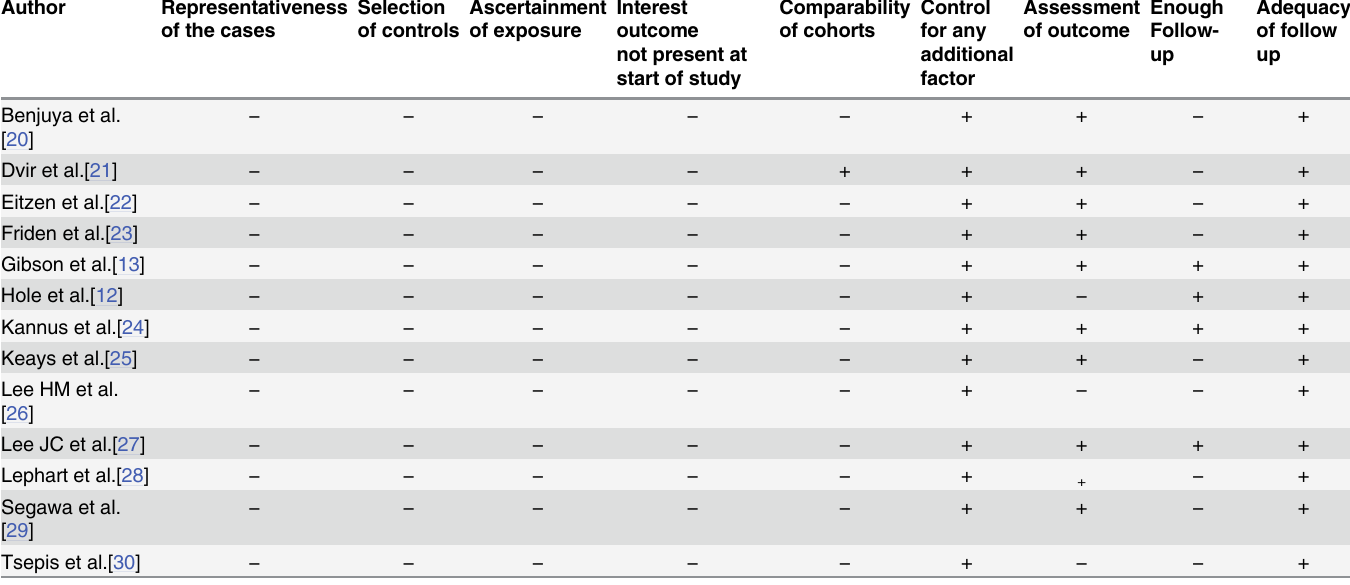
Table 2. Risk of bias summary: authors ’ judgments about each risk of bias item for each included